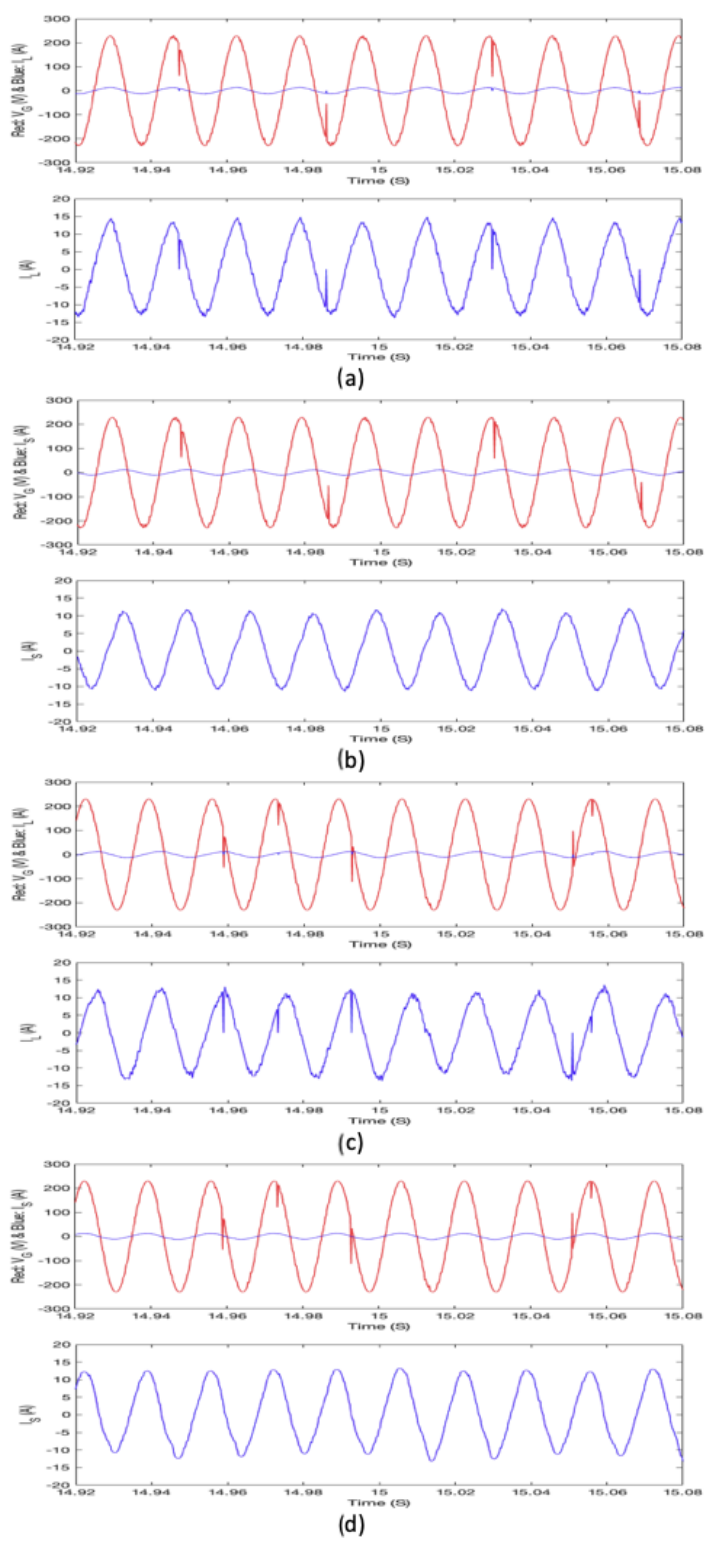
Figure 12. Experimental results: ( a ) the inverter’s output voltage (red) and current (blue) in active power compensation mode; ( b ) the AC grid’s output voltage (red) and current (blue) in active power compensation mode; ( c ) the inverter’s output voltage (red) and current (blue) in reactive power compensation mode; ( d ) the AC grid’s output voltage (red) and current (blue) in reactive power compensation